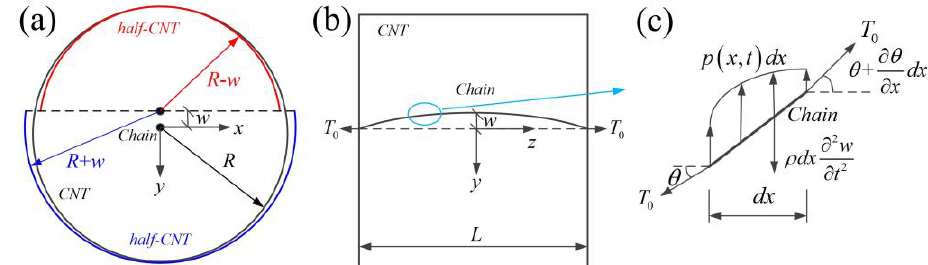
Figure 2. ( a ) The moving position of a point on a carbon chain in view of the carbon chain vibration in an SWCNT; ( b ) The side view of the carbon chain under initial tension in (a); ( c ) The vdW force distribution on the carbon chain under initial tension.